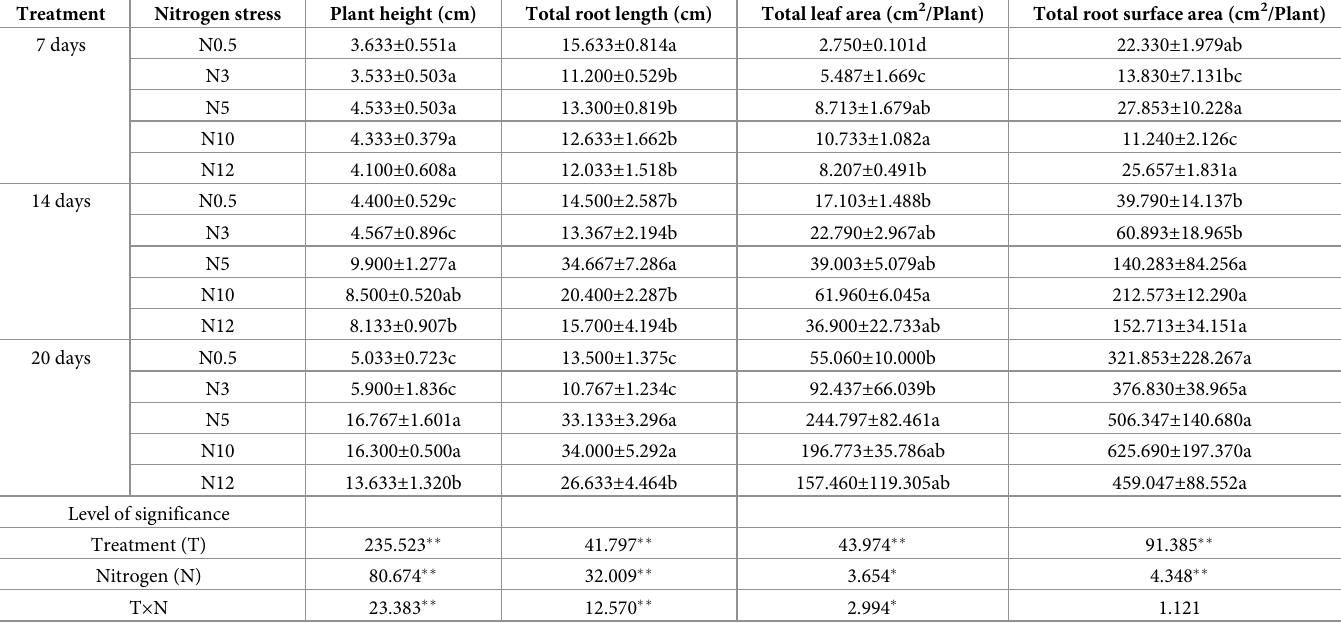
Table 2. Changes in the growth of sugar beet seedlings under different N treatments.